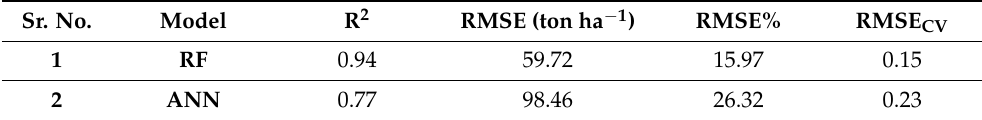
Figure 11. Scatterplot of the predicted Vs observed biomass (ton/ha) based on the ANN model. Table 1. Statistical parameters for the models.